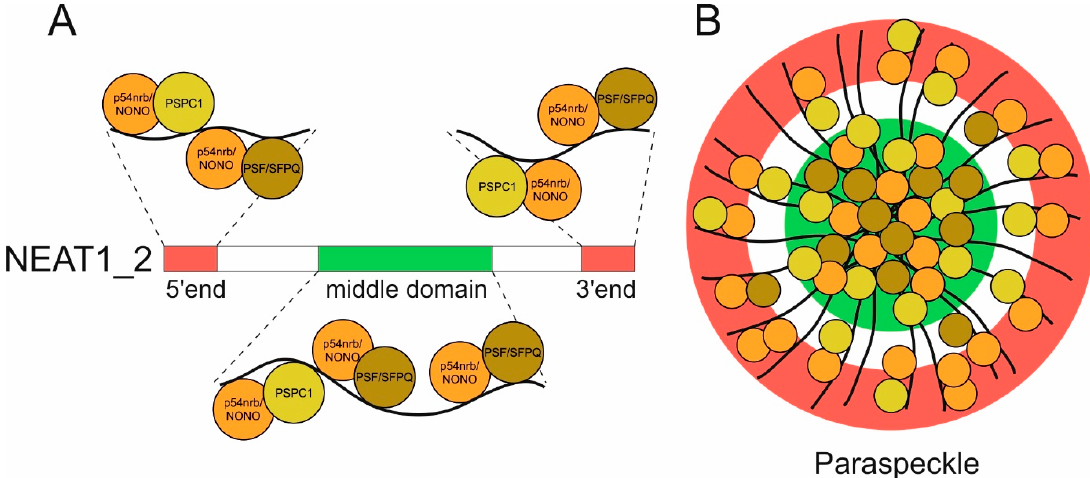
Figure 1. Nuclear enriched abundant transcript 1 ( NEAT1 )’s domain architecture and schematic paraspeckle structure. ( A ) The long isoform of NEAT1 ( NEAT1_2 ) contains three domains which are relevant for binding the paraspeckle-associated proteins 54 kDa nuclear RNA- and DNA-binding protein/non-POU domain-containing octamer-binding protein (p54nrb/NONO; orange), paraspeckle component 1 (PSPC1; yellow), and polypyrimidine tract-binding protein PTB-associated splicing factor/splicing factor proline glutamine rich (PSF/SFPQ; brown). p54nrb/NONO and PSF/SFPQ directly interact with NEAT1 ’s middle domain, whereas three protein interaction sites near the 5’ and the 3’ end facilitate binding of p54nrb/NONO. All three abovementioned proteins form heterodimers in every possible combination, and thus contribute to the formation of paraspeckles. Only proven interactions of proteins with NEAT1 and each other are shown. ( B ) Paraspeckles are arranged in a spheroidal, highly ordered structure with NEAT1 ’s middle domain being located in the center while its 5’ and 3’ termini are at the periphery of the structure. Paraspeckle-associated proteins p54nrb/NONO, PSF/SFPQ, and PSPC1 (as well as other paraspeckle proteins; not shown in figure) are distributed within the structure in consideration of the before established binding domains on NEAT1 .